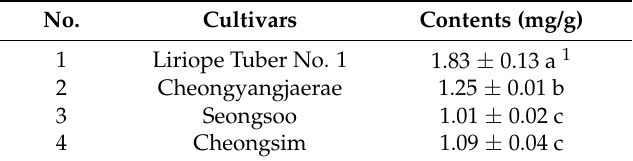
Table 1. Spicatoside A content in different cultivars of Liriope platyphylla .